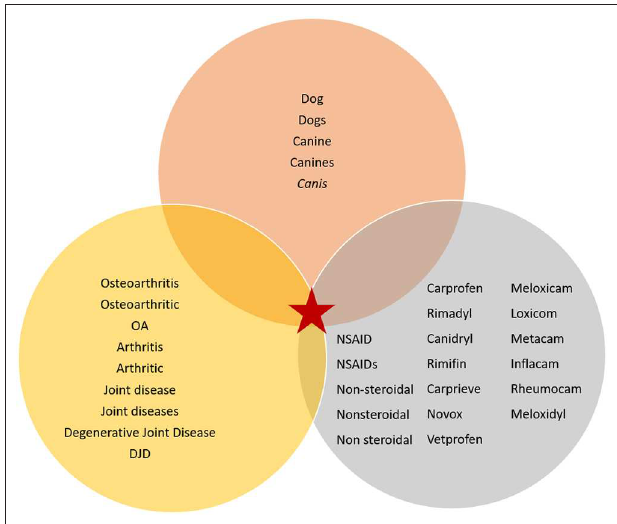
FIGURE 4 | Venn diagram illustrating the interaction between the different search terms within the search components for the example scenario (denoted by a red